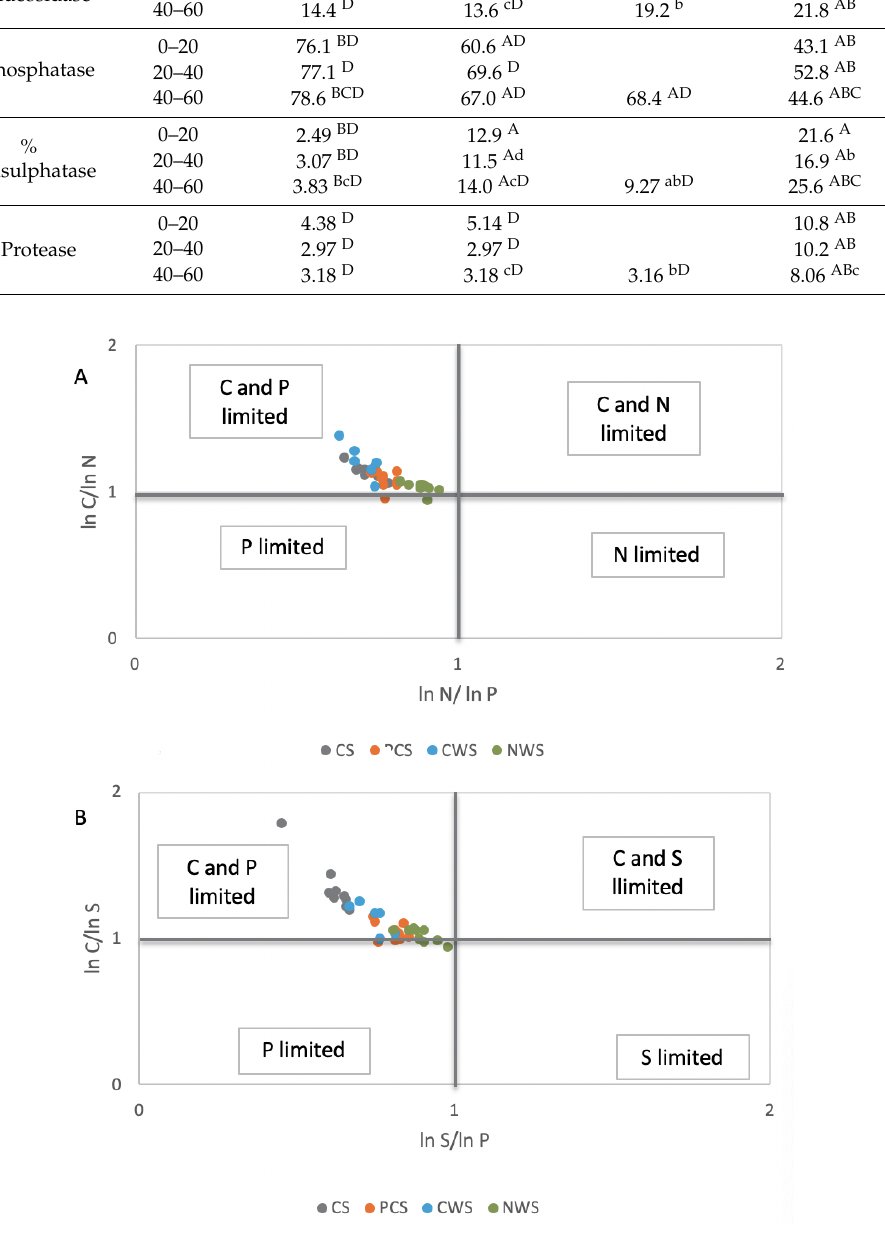
Figure 2. Scatterplots of soil ecoenzymatic stoichiometry for studied sites. ( A ) Proteases / phosphatase (N-acquiring enzymes / P-acquiring enzymes) as x -axis, and β -glucosidase / proteases (C-acquiring enzymes / N-acquiring enzymes) as y -axis. ( B ) Arylsulphatase / phosphatase (S-acquiring enzymes / P-acquiring enzymes) as x -axis, and β -glucosidase / arylsulphatase (C-acquiring enzymes / S-acquiring enzymes) as y -axis. CS, in grey color; PCS, in orange color; CWS, in light blue color; NWS in green